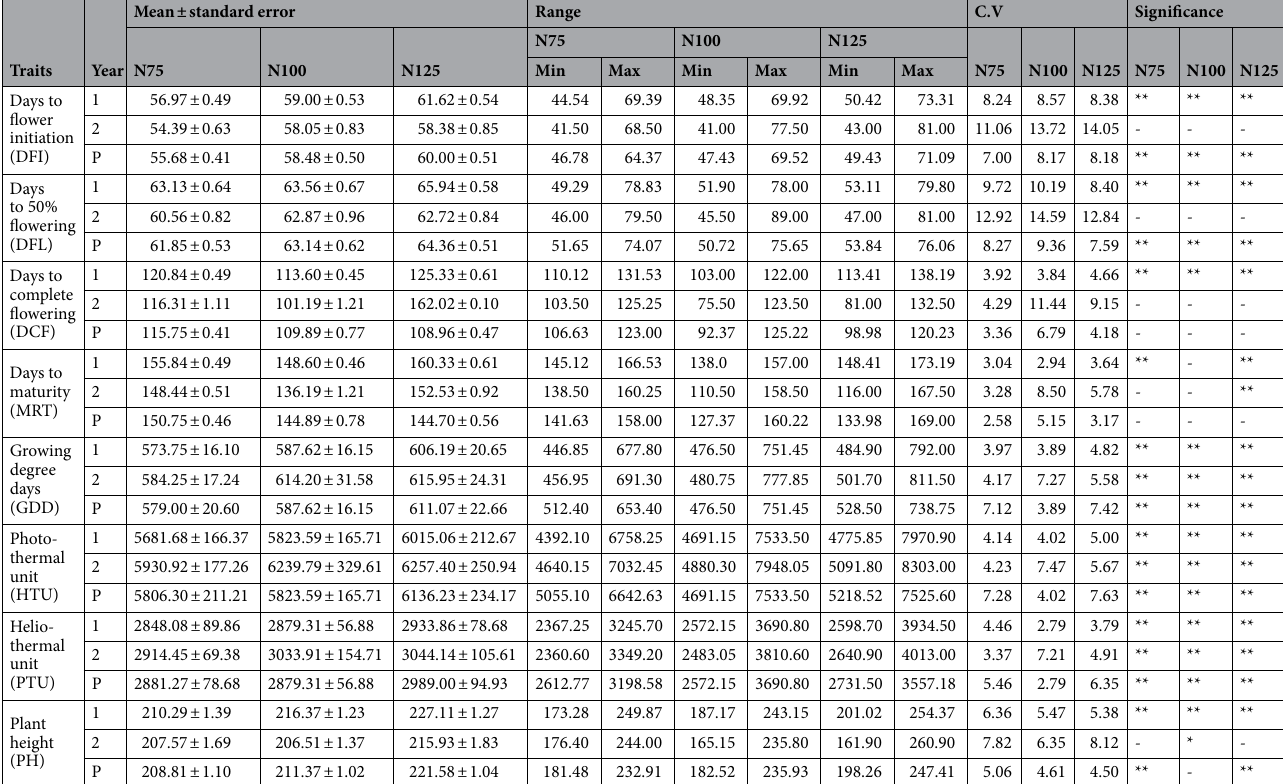
Table 1. Basic descriptive statistics of flowering traits in B. juncea diversity fix foundation set ( BjDFFS ) during 2015–16 and 2016–17. P pooled. **Significant at 1% level. *Significant at 5% probability level. Analysis of variance for the design was used for the test of